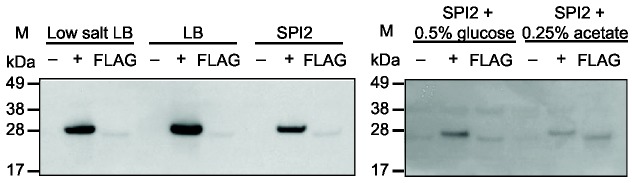
SDS-PAGE and western blot analysis of epitope-tagged YehT protein from S.
Typhimurium ST4/74. Proteins from whole cell bacterial lysates were transferred after electrophoretic separation in a 12% SDS-PAGE gel (Invitrogen) onto a nitrocelluose membrane (Invitrogen) and probed with anti-FLAG M2 monoclonal antibodies (Sigma). Lanes: (M) protein molecular weight markers (SeeBlue Plus2 Pre-stained standard; Invitrogen); (-) proteins extracted from S. Typhimurium ST4/74 (negative control); (+) proteins extracted from S. Typhimurium SL1344 ΔfliA (positive control; 27.4kDa); FLAG proteins extracted from S. Typhimurium ΔyehT-tagged (27.4kDa). Bacteria was grown in low salt LB; normal salt LB; SPI-2 inducing; SPI-2 + 0.5% glucose; SPI-2 + 0.25% acetate overnight, shaking at 37°C.